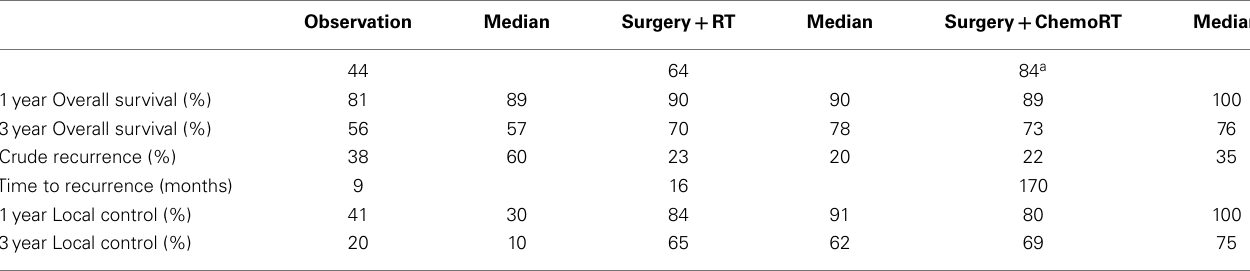
Table 2 | Outcome summary of retrospective studies.